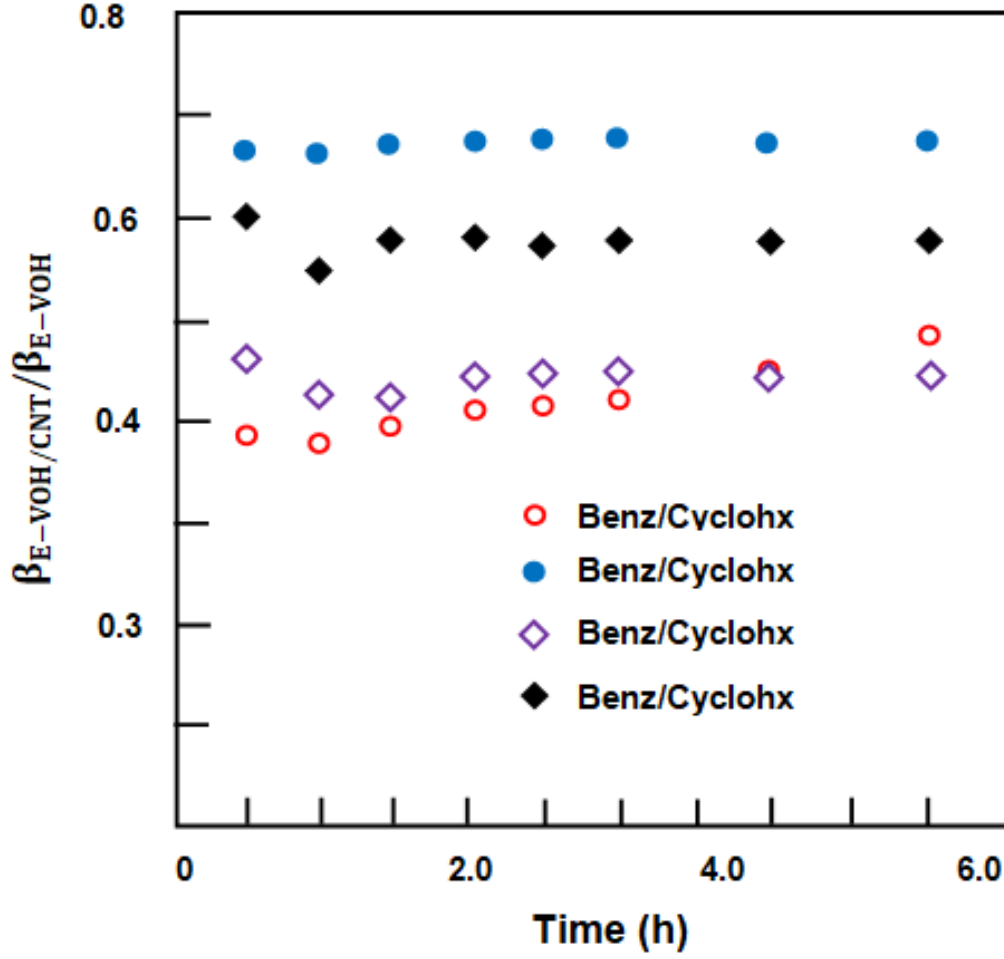
Figure 17. Variation of the β E − VOH / CNT / β E − VOH ratio versus time for the di ff erent feed compositions. Finally, it can be said that the best performance of the filled membrane in terms of total cumulative flux and selectivity are obtained for the feed containing the azeotropic